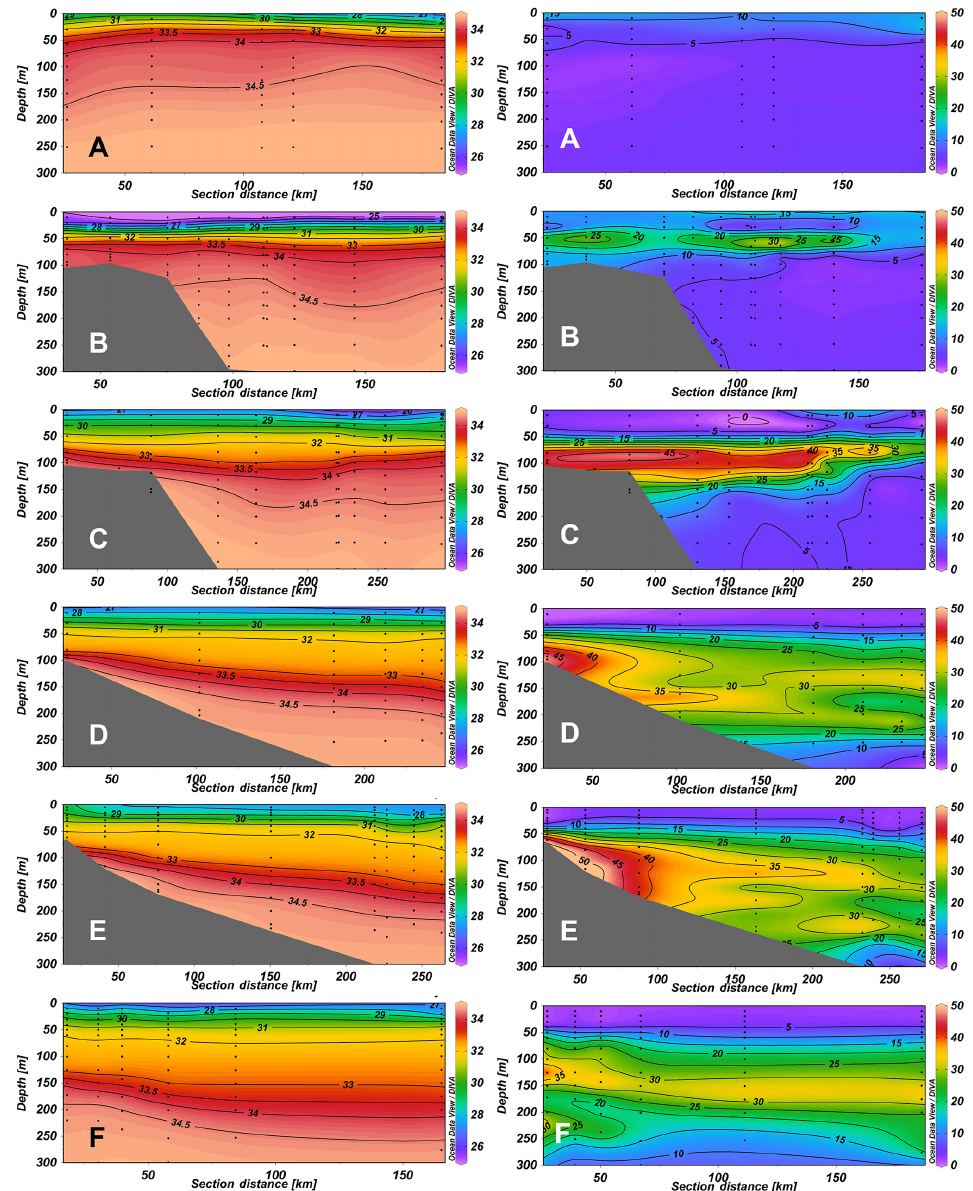
Figure 2. Sections of salinity (left) and silicate in µmolL − 1 (right) of the upper 300m of sections A to F; see Fig. 1 for location of sections. Sections drawn using Ocean Data View (Schlitzer,